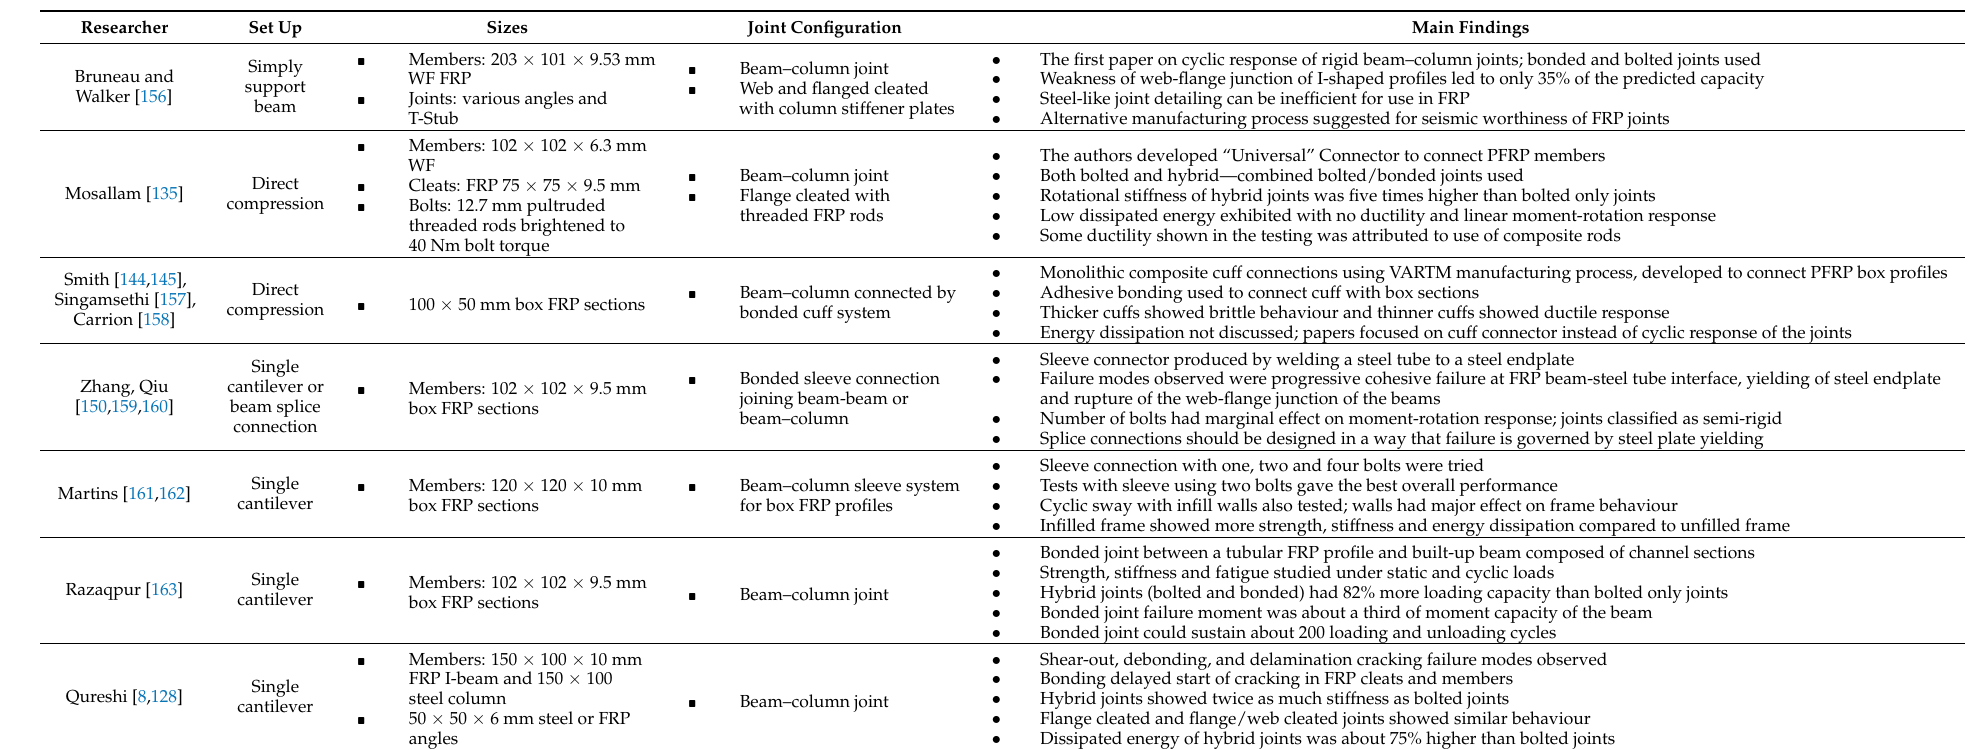
Table 7. Main findings for FRP frame joints subjected to cyclic